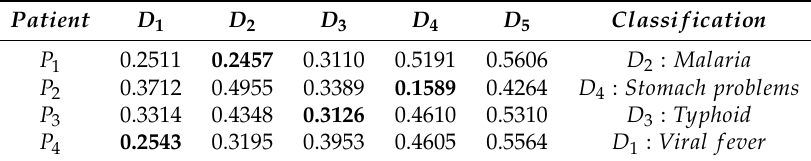
Table 13. The results generated by Xiao’s method in Exmple